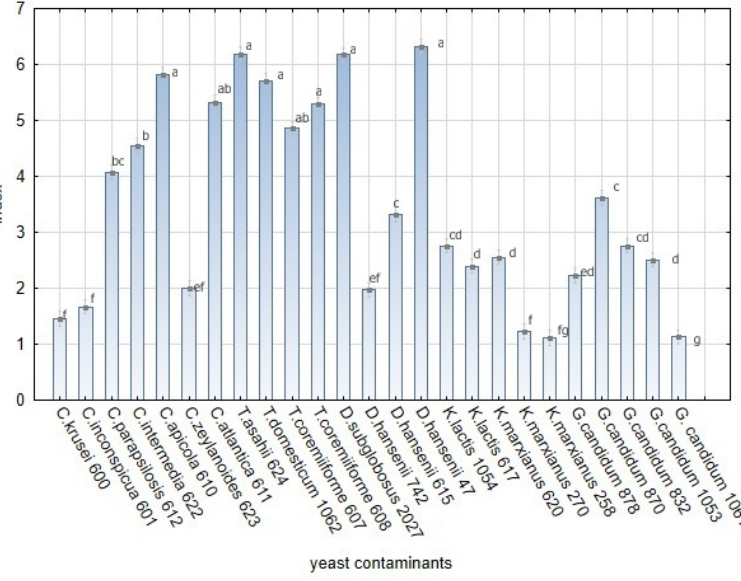
Figure 9. The sensitivity of yeast strains to L. plantarum strains in in vitro overlay tests. The bars represent the means of index value and SEM. F (24, 1050) = 400.009; p ≤ 0.00 E ≤ 0.05 (Factorial ANOVA, Statistica Software v. 12, Post Hoc Tukey’s HSD Test). The index letter indicates significant differences. Significant at α ≤